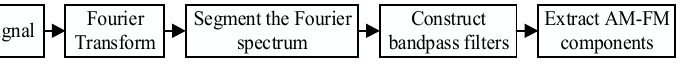
Figure 2. EWT workflow.